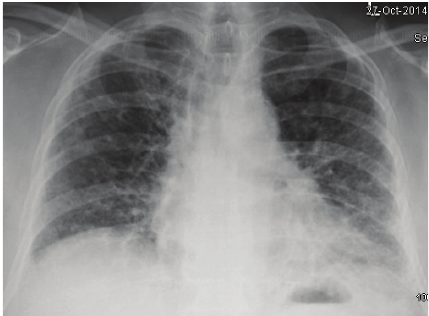
Figure 1: Chest X-ray taken 6 months prior to the day of admission showing mild hazy changes in bilateral lung fields.